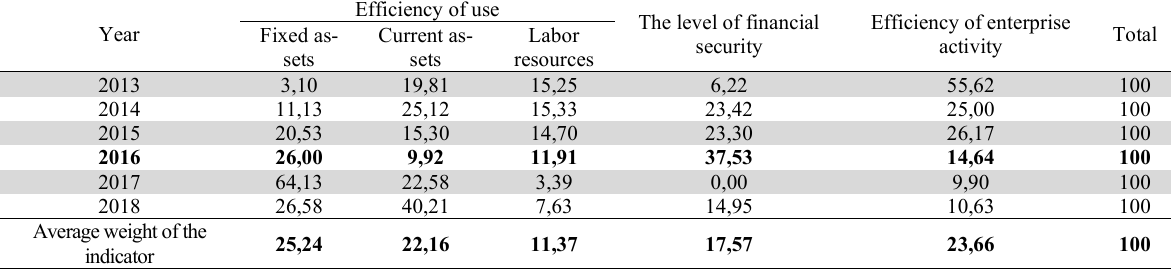
Average weight of the